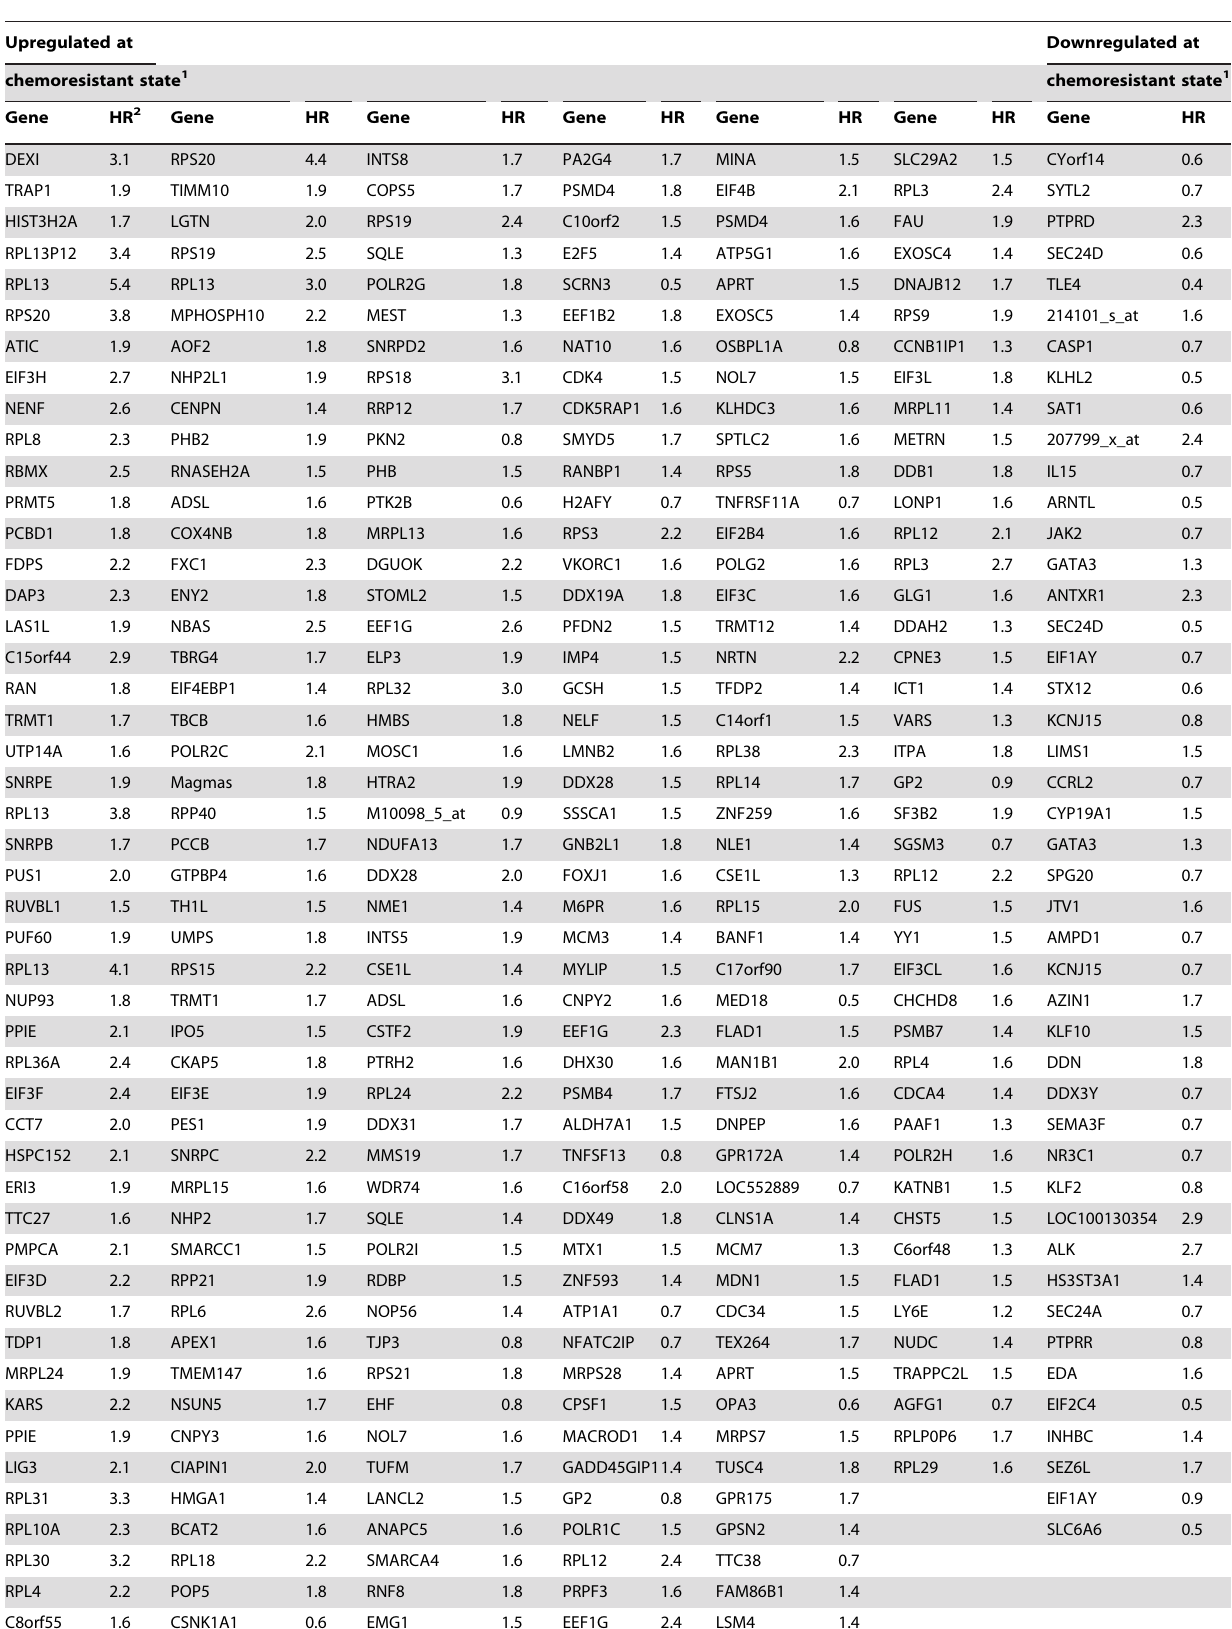
Table 2. Genes Which Belong to the Acquired Resistance Signature (selected at P , 0.05) and Were Correlated with TTP of 101 Non-rebiopsied Patients at P ,